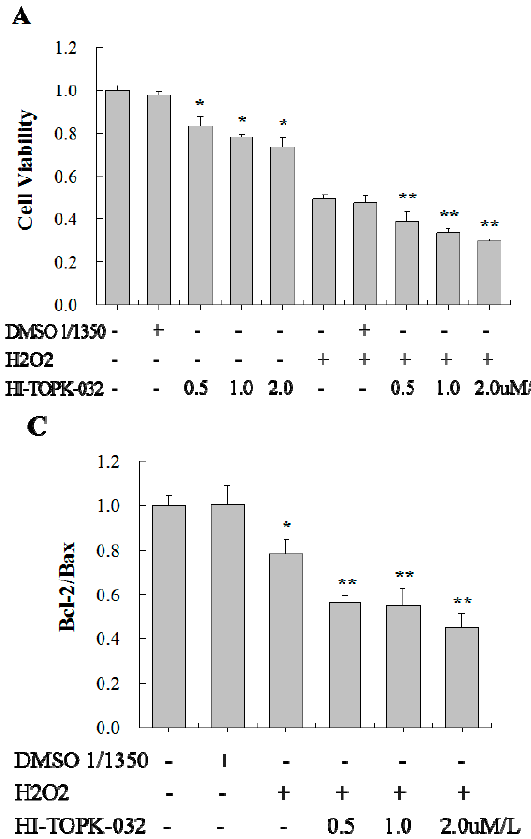
Figure 4. Analysis of the effects of the TOPK specific inhibitor HI-TOPK-032 on cell viability, apoptosis, and protein expression. H9C2 cardiomyocytes were incubated with HI-TOPK-032 at concentrations of 0.5, 1.0, and 2.0 µM for 24 h and then stimulated with 750 µM of H 2 O 2 for 1 h. Dimethyl sulfoxide (DMSO) was used as a solvent control. ( A ) Cell viability as detected by MTS assay; ( B ) Western blot analysis of Bcl-2, Bax, ERK, and p-ERK expression. β -actin was used as a loading control; ( C ) The Bcl-2/Bax ratio was calculated and compared. * p < 0.05 compared with nonstimulated controls; ** p < 0.05 compared with H 2 O 2 -stimulated controls.